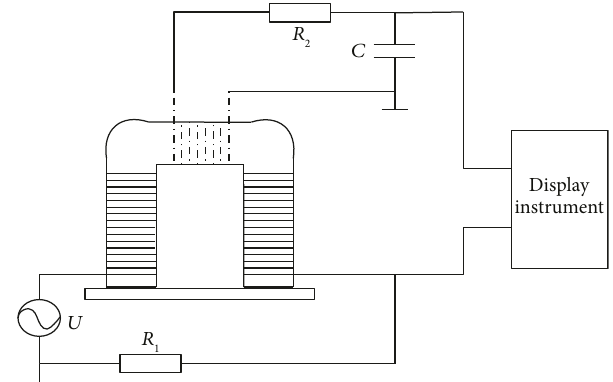
Figure 5: Schematic diagram of coercive force measurement by the yoke